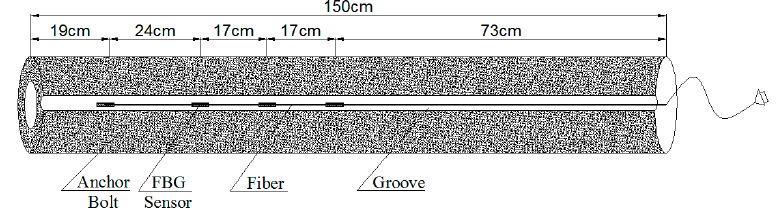
Figure 3. The concrete structure of the FBG force-measuring bolt-shaft.